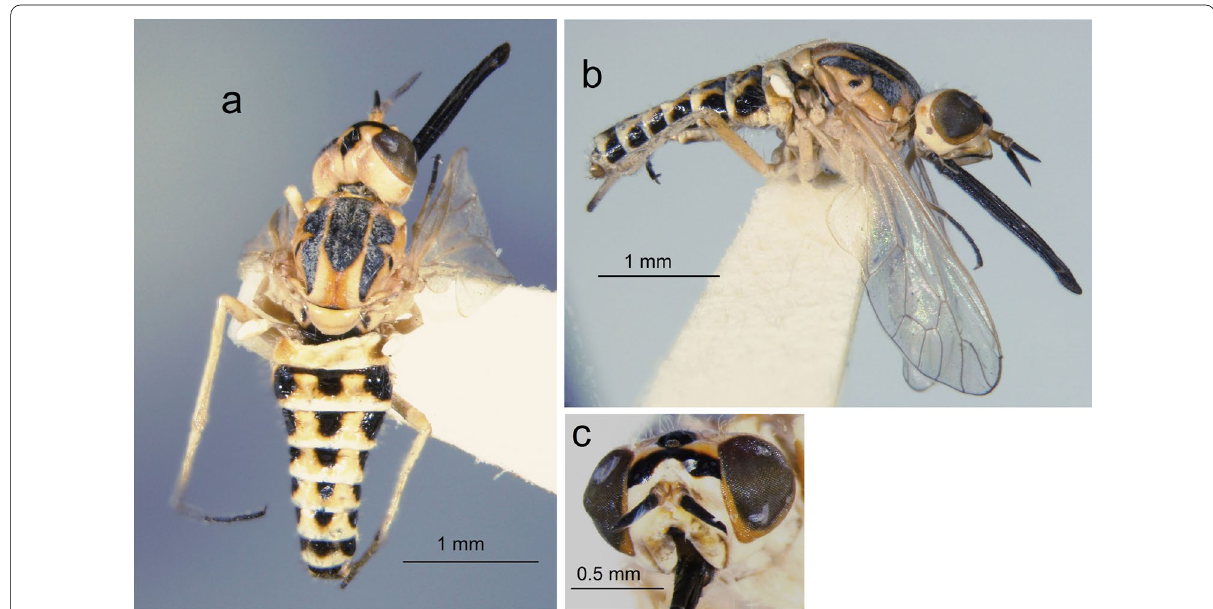
Fig. 2 Heterotropus maculiventris Bezzi. a Female habitus, dorsal view. b Same, lateral view. c Head, frontal